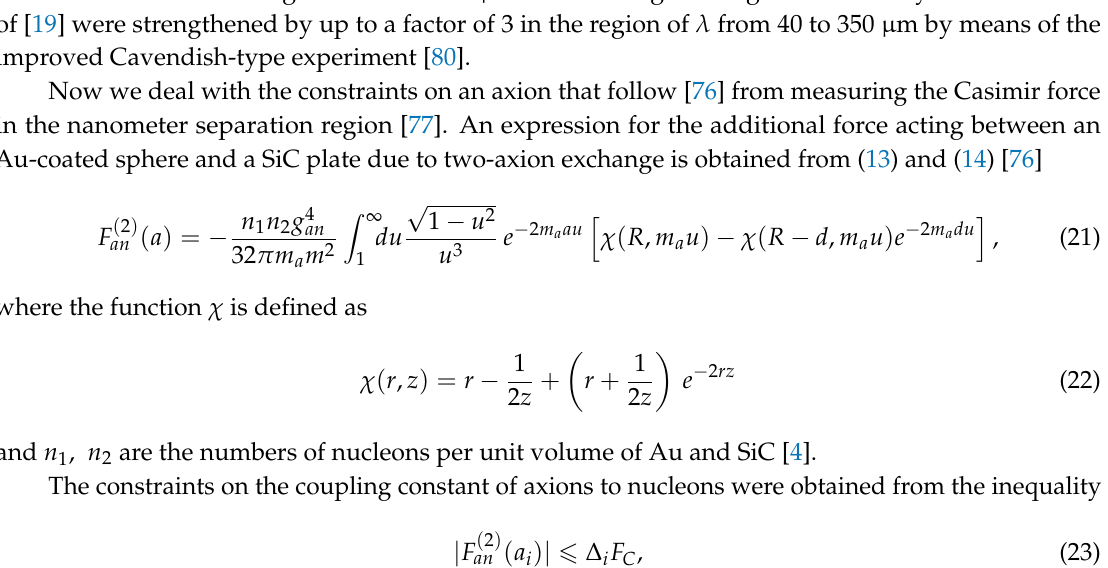
Figure 7 by the two lines labeled “n”. As is seen in Figure 7, the neutron scattering results in the strongest constraints on α up to λ = 10